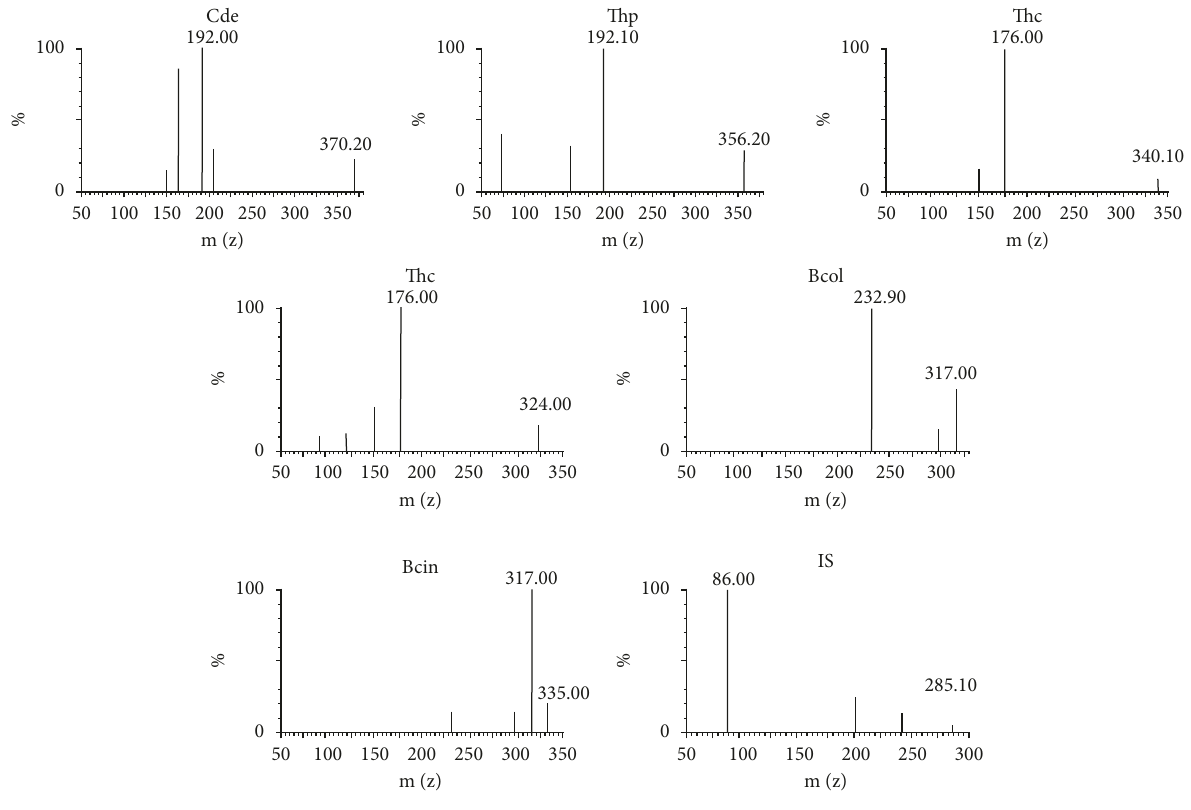
Figure 3: The MS/MS spectra of the analytes and